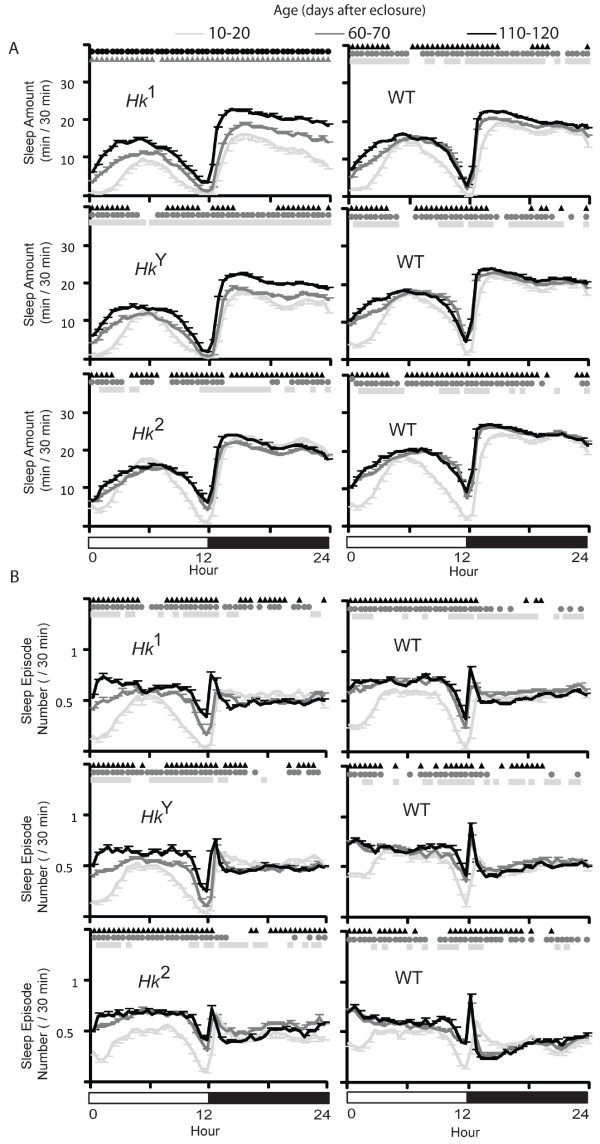
Time course of sleep parameters in flies that lived at least 73 days. Values are mean + SEM (eleven 30-min intervals averaged per each fly, and then averaged across all flies). Comparisons (Friedman test followed by Wilcoxon signed-rank test, p < 0.05) are between the 10-20 day period and all following ages: triangle (vs 35-45), circle (vs 60-70), square (vs 85-95), diamond (vs 110-120). Data are derived from the same flies used in Figures 5 and 6.